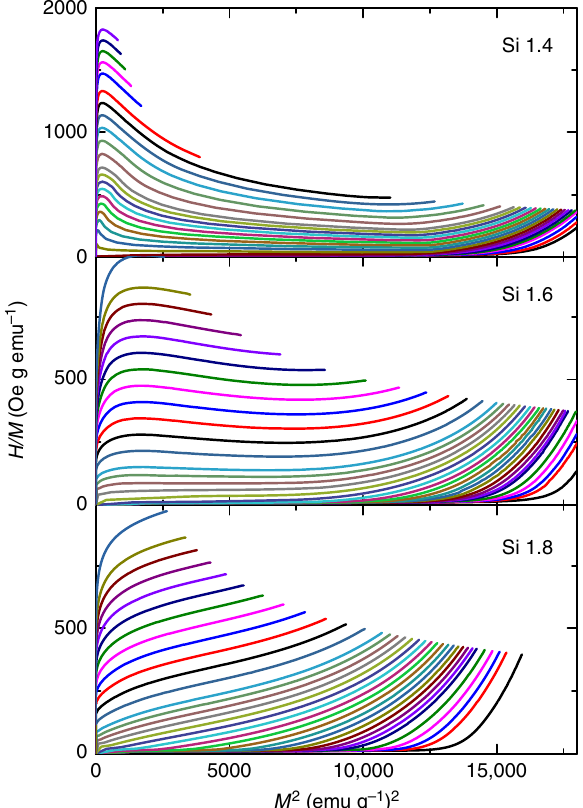
Fig. 2 Arrott plots for the Si 1.4, Si 1.6 and Si 1.8 samples. According to Banerjee criterion, both Si 1.4 and Si 1.6 samples exhibit FOPT while Si 1.8 undergoes a